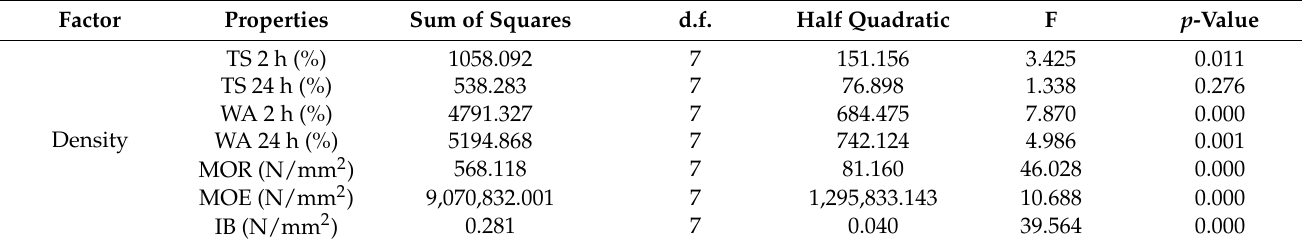
Table 3. ANOVA of the results of the